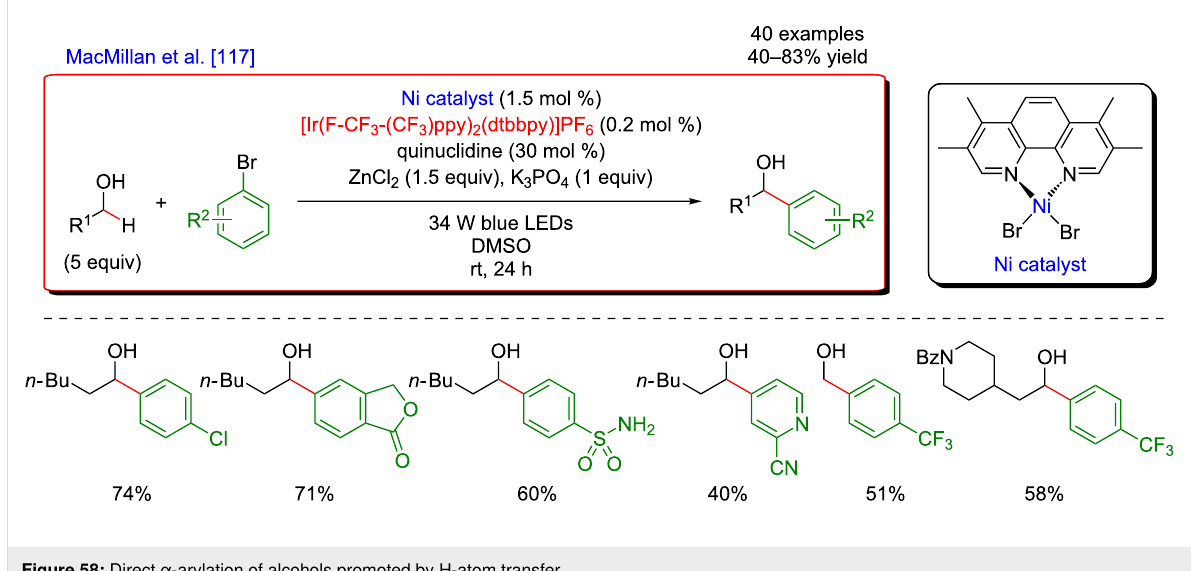
Figure 58: Direct α -arylation of alcohols promoted by H-atom transfer.